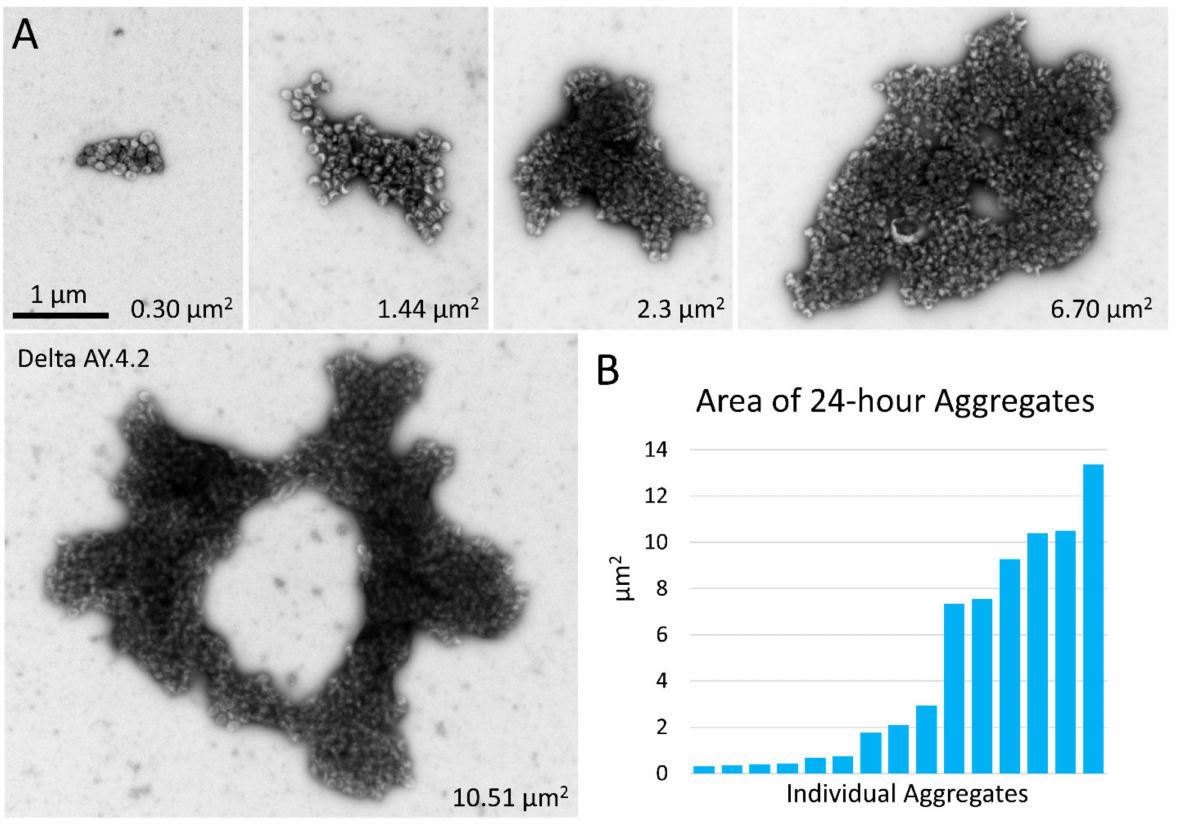
Figure 3. Negative stain TEM of Delta and Delta AY.4.2 aggregates 24 h after harvest from producer cells. ( A ) Images of aggregates of Delta and Delta AY.4.2 PVs representing a range of sizes observed after storage overnight at 4 ◦ C. The area occupied by each aggregate is indicated in the lower right corner. One donut-shaped Delta AY.4.2 aggregate is labeled, all other aggregates are Delta PVs (unlabeled). All images are scaled the same and scale bar is indicated. ( B ) Graph shows an ordered list of the areas of Delta